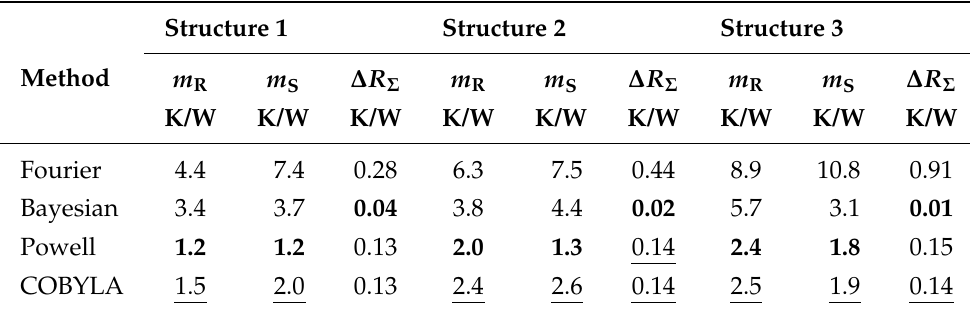
Table 2. Best accuracy for all methods in the absence of noise. The best performing method in each column is highlighted in bold, the second best result is underlined.